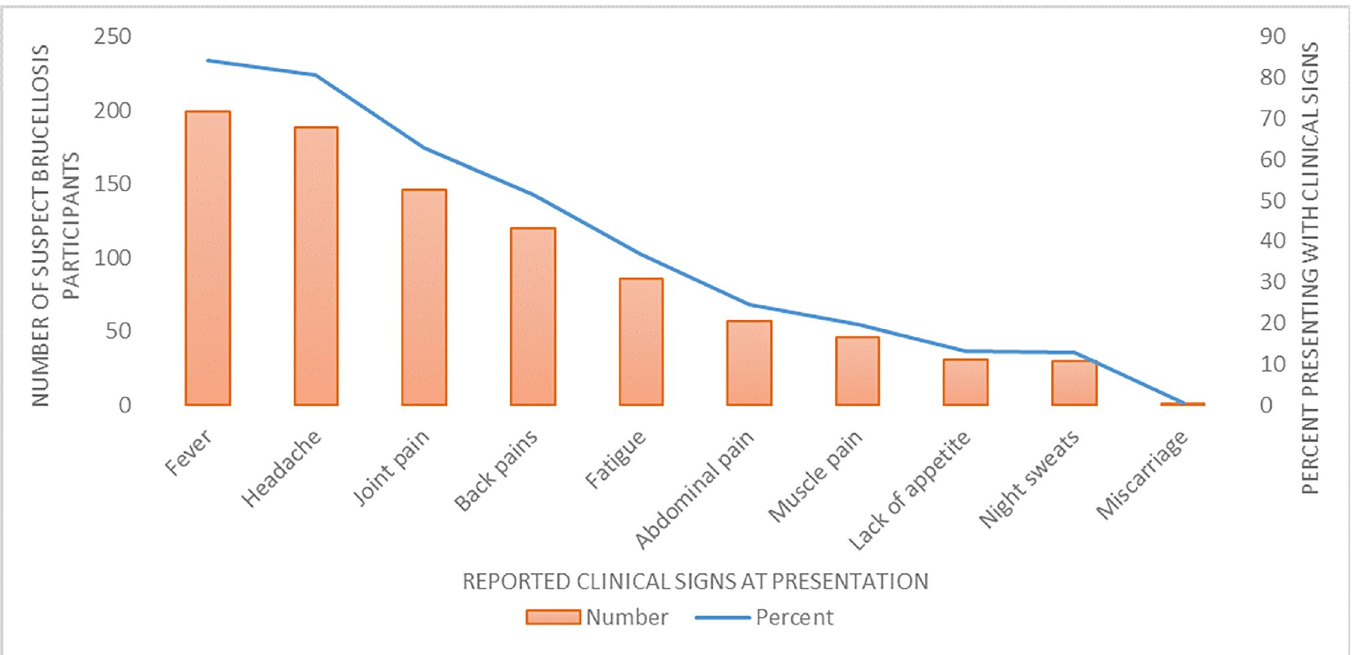
Fig 2. Reported clinical signs of enrolled cases at presentation at health facilities (N =